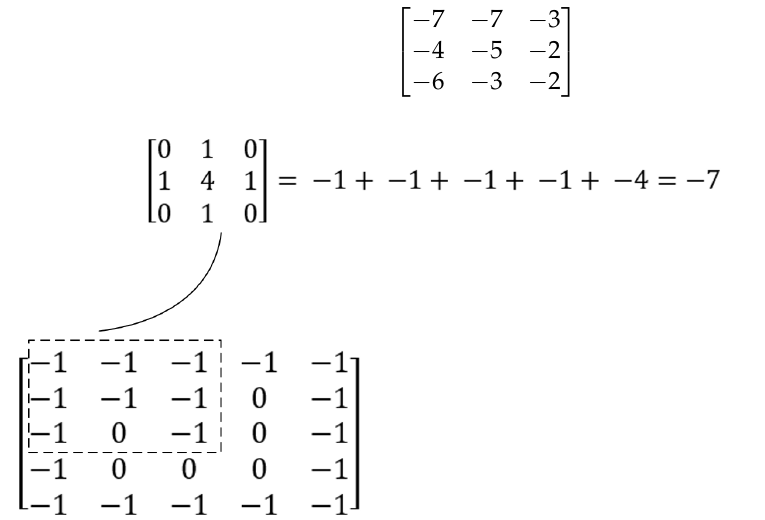
Figure 5. Remove non-overridable grid calculation